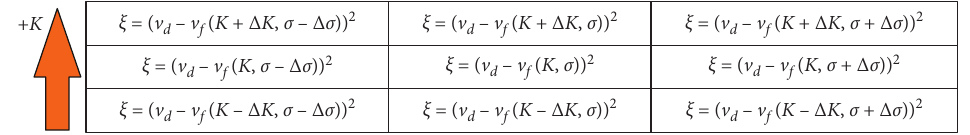
Figure 1: Basic scheme of the error matrix.